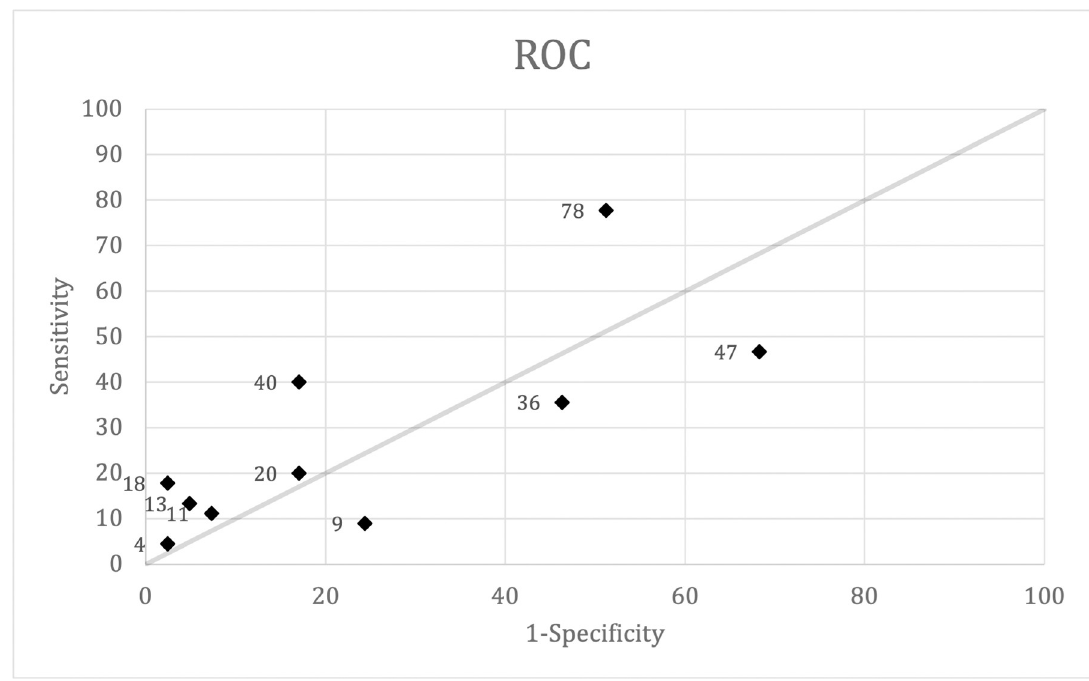
Fig 2. Receiver operating characteristics curve. Plotting clinical